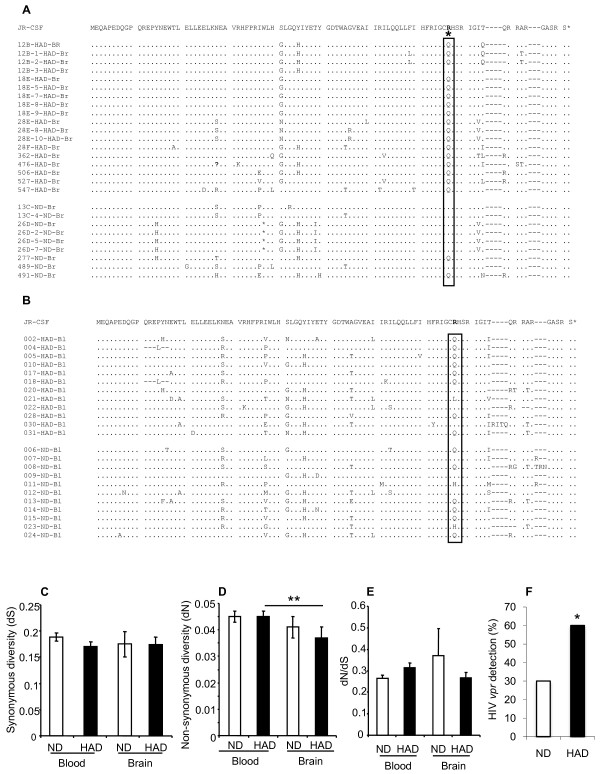
Brain- and blood-derived Vpr sequences. (A) Brain-derived sequences exhibited diversity in both the HAD and ND groups but a mutation at position 77 significantly distinguished the clinical groups with a Q predominating in the HAD group and an R being most evident in the ND group. (B) Blood-derived sequences also demonstrated molecular heterogeneity in both groups but there were no residues that distinguished the clinical groups. (C) The frequency of within-groups synonymous mutations was similar among all sequences from all clinical groups. (D) The frequency of within-group non-synonymous mutations was lower in the brain-derived HAD sequences compared with the blood-derived HAD sequences. (E) Conversely, the ratios of within-group non-synonymous to synonymous mutations did not differ within the clinical groups. (F) The frequency of detecting vpr sequences in brain was significantly higher in the HAD group compared with the ND groups (A, B, F: Mann-Whitney U test; C-D: ANOVA, Bonferroni post hoc test; *p < 0.05).